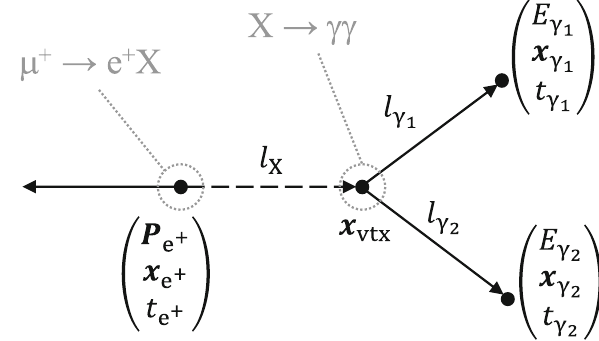
Fig. 7 Decay kinematics and kinematic